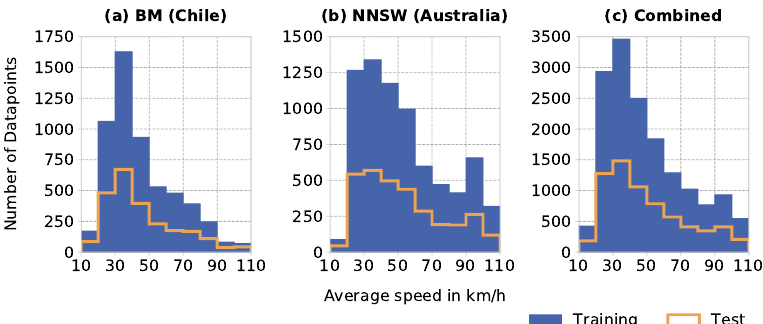
Figure 3. Distribution of the regression target variable (average speed values) in the training subset (blue) and the test subset (orange line) for all datasets.